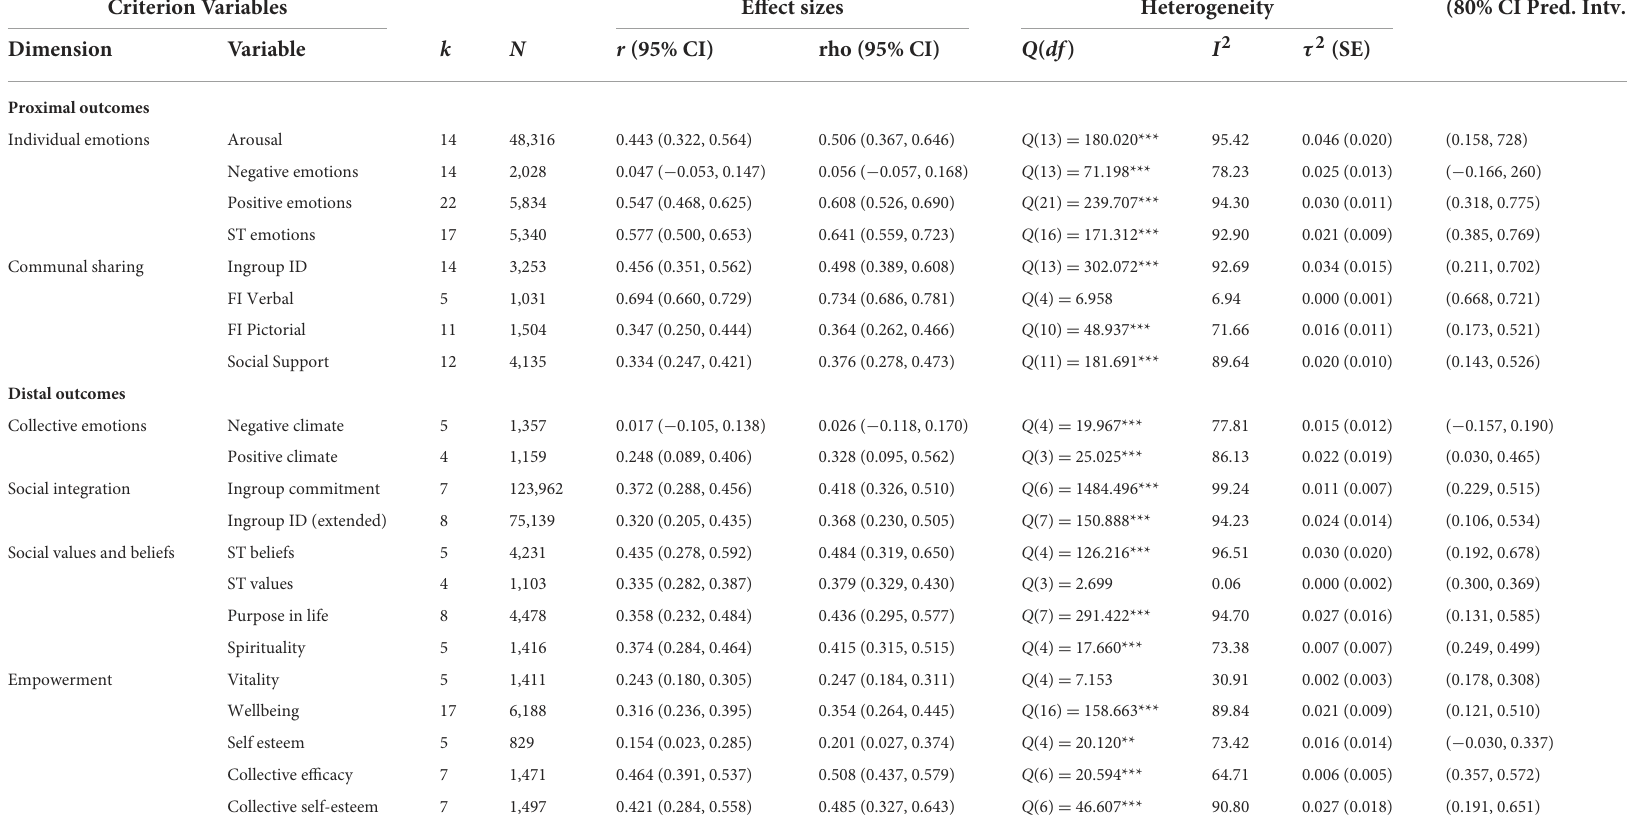
TABLE 3 Pooled correlations between collective effervescence and criterion